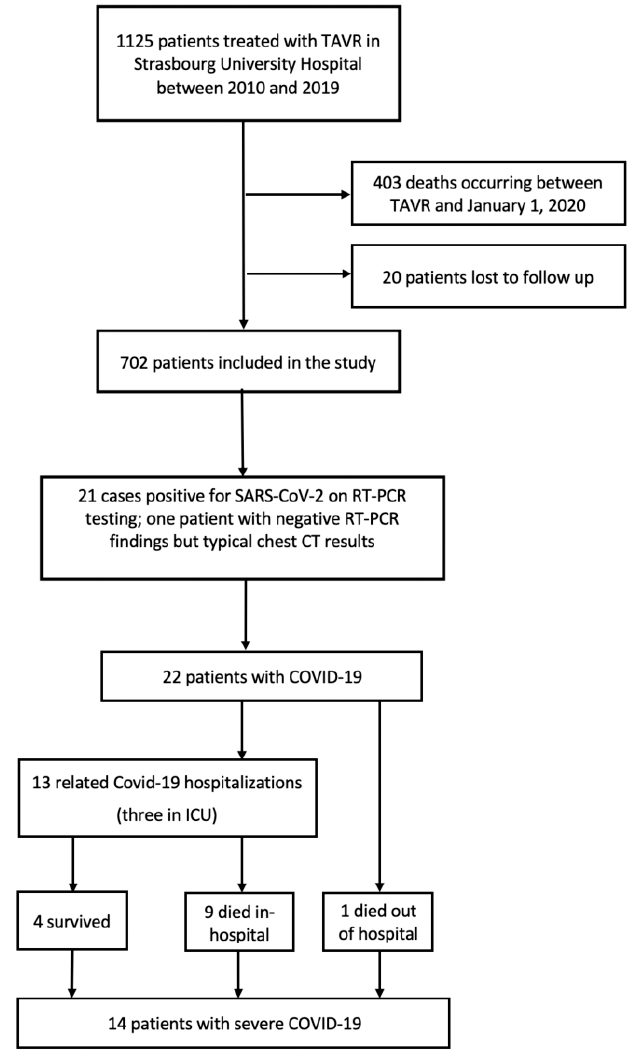
Figure 1. Flow chart of the study. Table 1. General characteristics of patients who had undergone transcatheter aortic valve replacement according to the presence or absence of COVID-19.